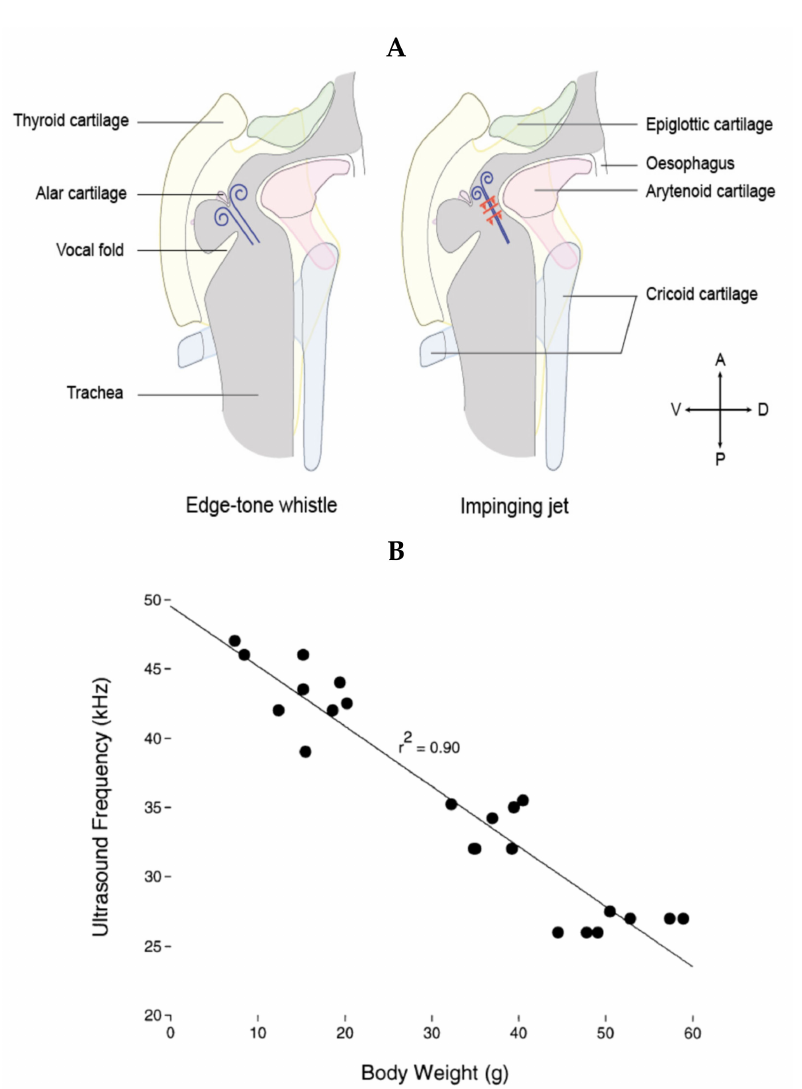
Figure 2. ( A ) Schematic of the proposed mechanisms for USV generation, with the edge tone whistle on the left and the impinging jet on the right. Constriction of the vocal folds leaves a small hole dorsally, through which the expiratory flow is constricted. The glottal exit jet is then either projected onto the alar edge formed by the alar cartilage (left) [92] or impinged against the thyroid wall (right) [91]. In the edge tone whistle mechanism, the ventral pouch would function as a resonator, while in the impinged jet mechanism, the upstream feedback travels back toward the glottis, generating the acoustic wave. Drawing of the larynx created from [3,94,95]. ( B ) In both models, the frequency and modulation of the USV depends on the laryngeal shape, itself determined both by the anatomy of the animal and the activity of the laryngeal muscles controlling the shape of the glottis. Accordingly, as the animal grows, the fundamental frequency of its longest USV lowers. Figure reproduced with permission from